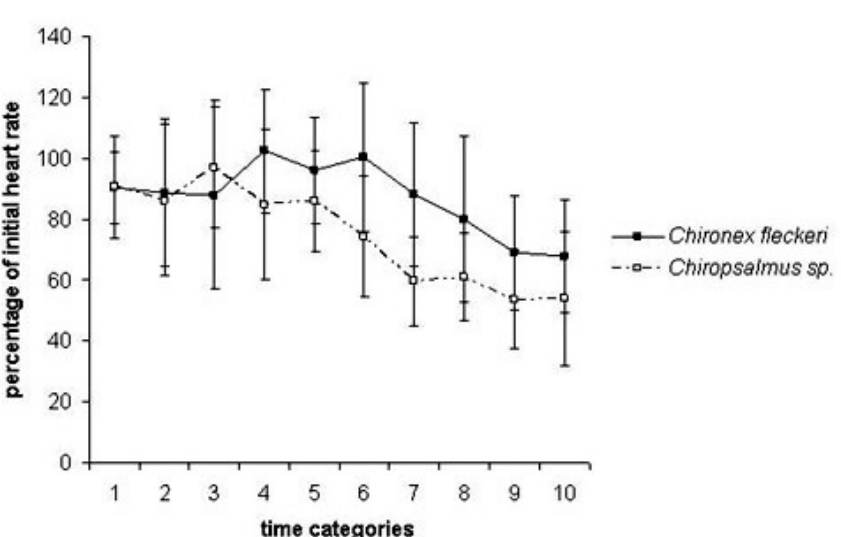
Figure 2: Percentage of initial heart rate over time category for animals envenomed with Chironex fleckeri and Chiropsalmus sp. venom (95% confidence limits